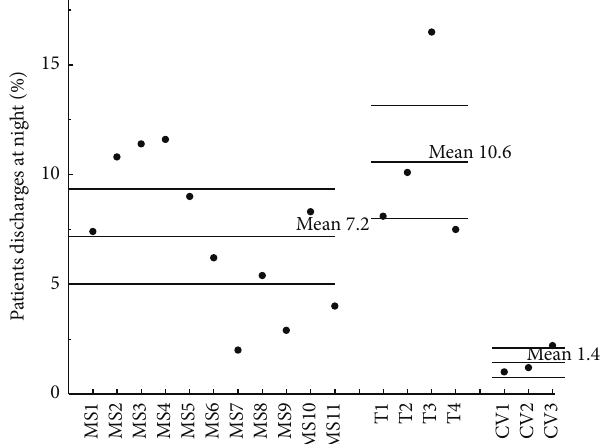
Figure 2: Percent of patients discharged at night. x-bar statistical process control chart with rational subgrouping by unit type (from left to right: mixed medical surgical (MS), trauma (T), and cardiovascular (CV)). The upper and lower control limits are set at 3 𝜎